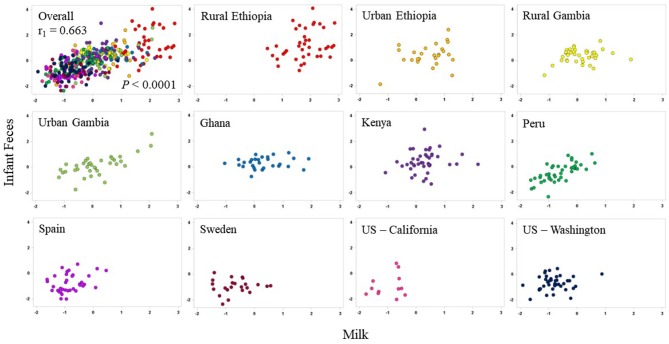
Canonical correlations between aggregations of the 10 most-abundant bacterial genera in milk (x-axes) and aggregations of the 10 most-abundant bacterial genera in infant feces (y-axes) in each cohort. The overall correlation is plotted in the upper-left panel; individual cohorts are illustrated in subsequent plots.